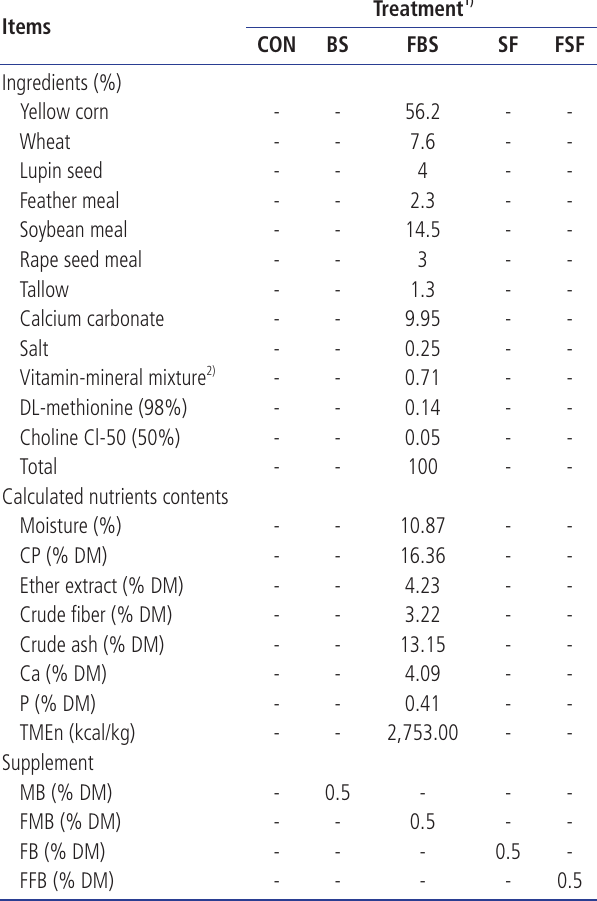
Table 2. Formula and calculated nutritional values of the basal diet